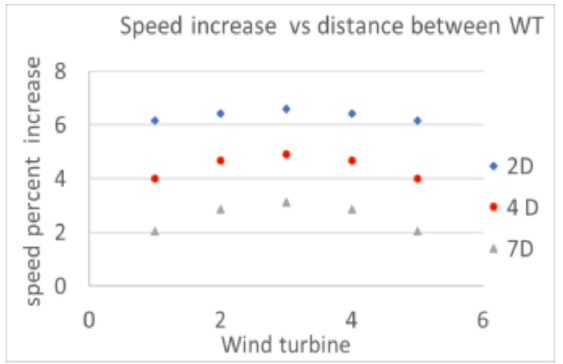
Figure 18. Five turbines with a distance varying among two, four, and seven wind turbine rotor diameters. The percent of the speed increase in front of a wind turbine row compared to a row of one